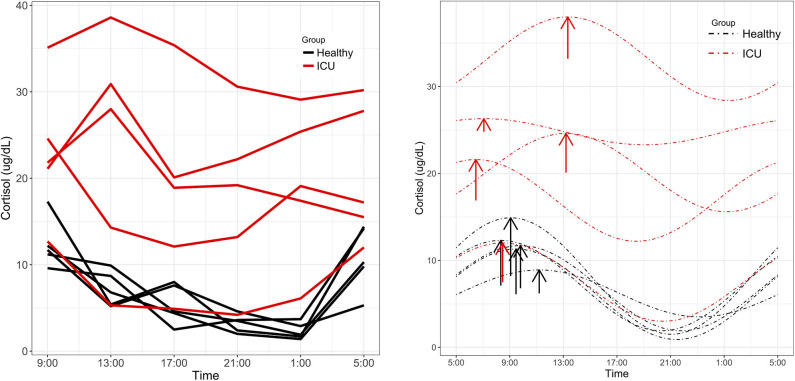
Cortisol rhythms. (Left) Individual time series plots of cortisol concentrations quantified by Fairview Hospital Laboratories. Red lines indicate measured cortisol concentrations in ICU patients and black lines indicate healthy controls. (Right) ICU patients showed alterations in MESOR and phase not present in controls. Dashed lines represent cosinor fits to the data. Arrows are placed at each rhythm's acrophase. Arrow lengths reflect rhythm amplitude.